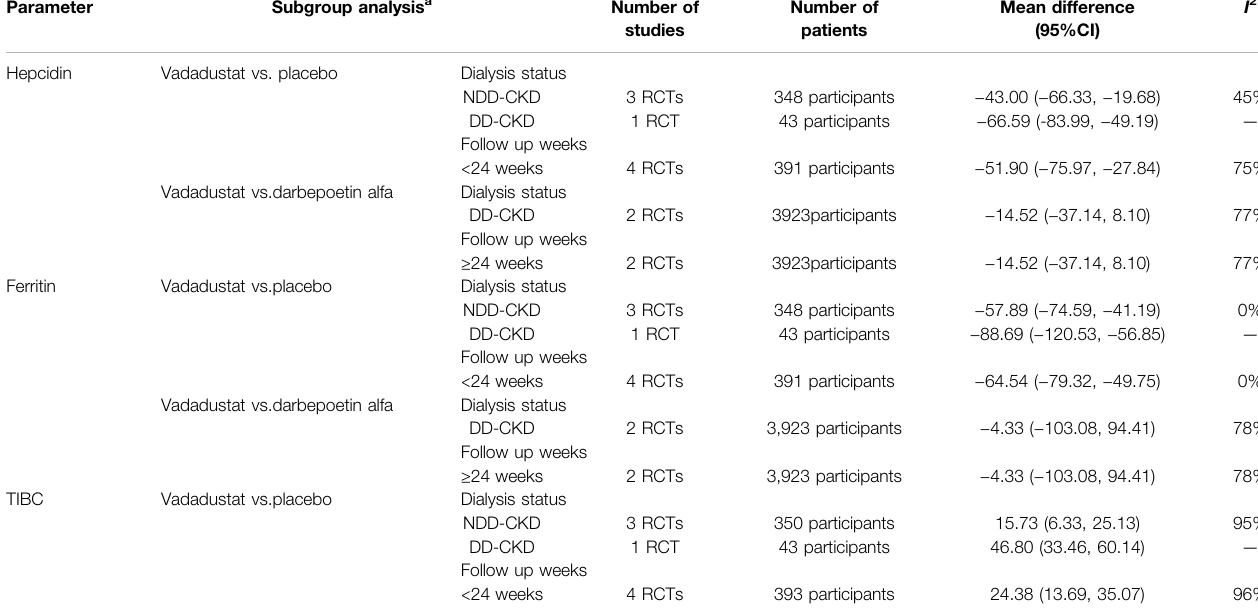
TABLE 4 | Subgroup analysis of iron metabolism